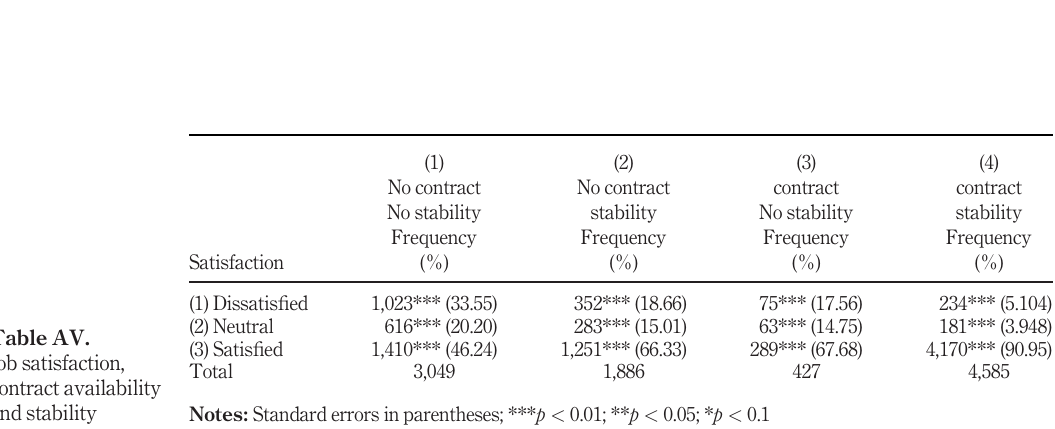
Table AIV. Job satisfaction level in the public* and the private sector**